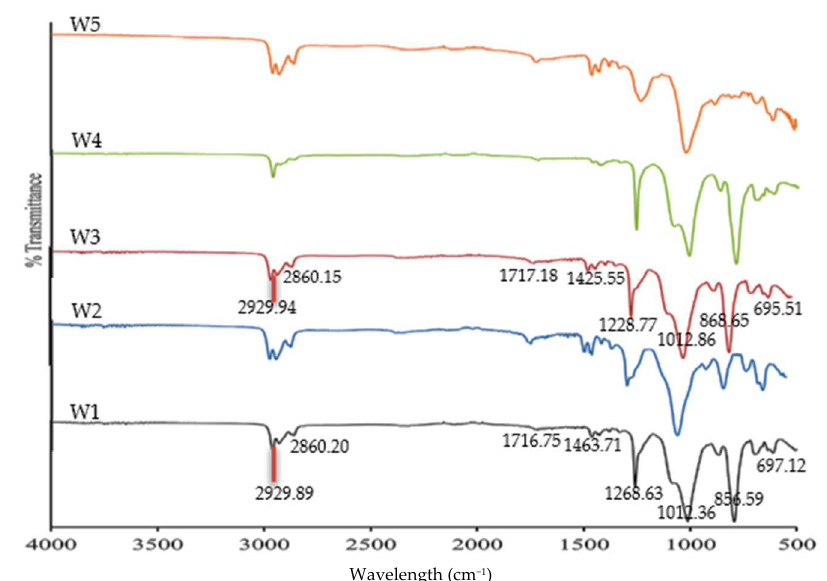
Figure 4. The FTIR spectra of the fabricated membranes after Zn 2+ removal.